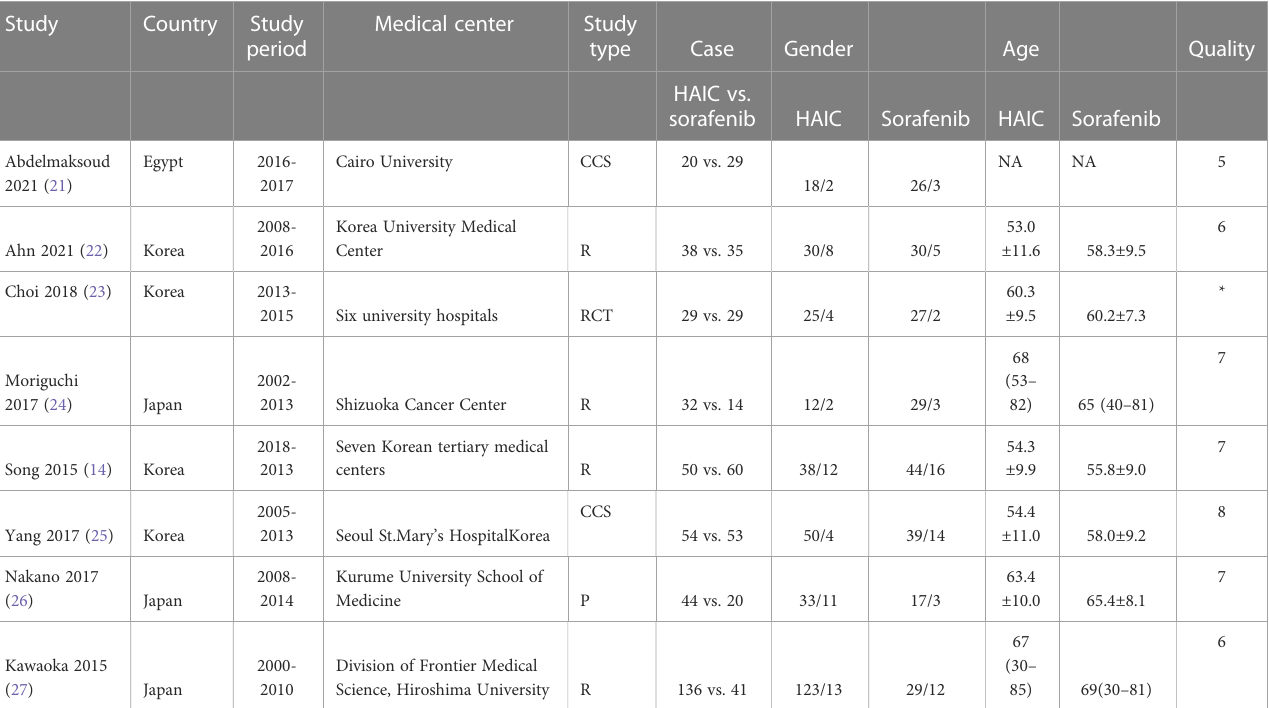
TABLE 1 Basic characteristics of the included